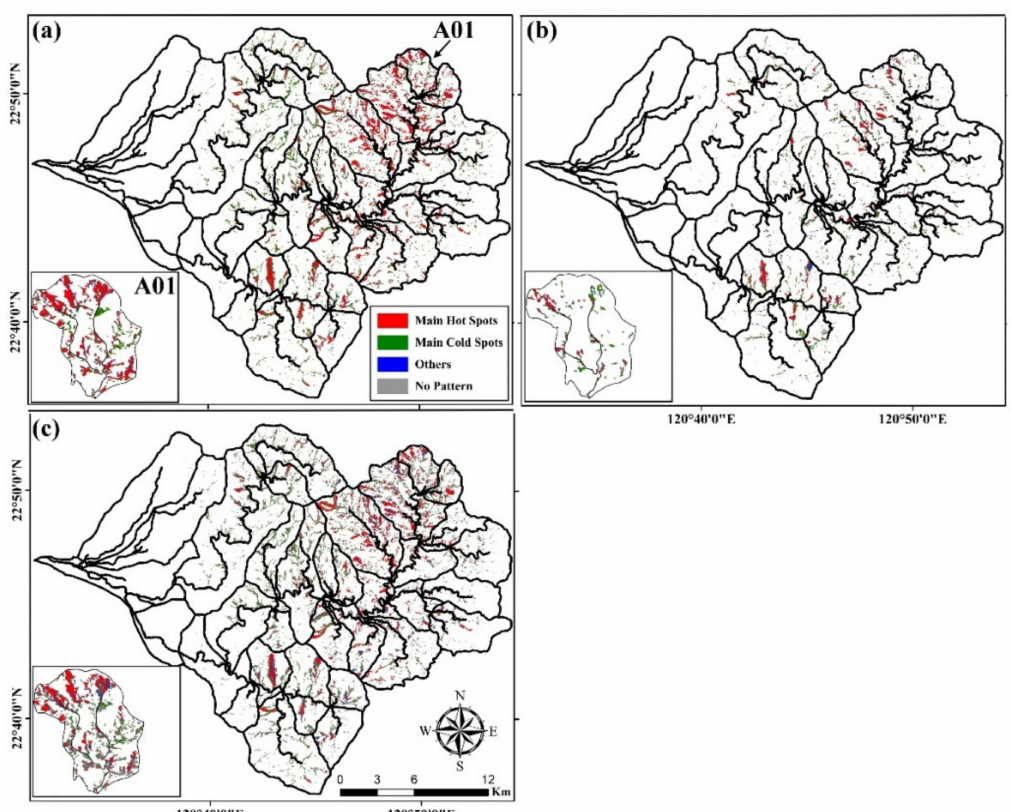
Figure 11. The main landslide hot spot and cold spot from 2005 to 2015 ( a ), from 2005 to 2008 ( b ), and from 2010 to 2015 ( c ) in the ARW .